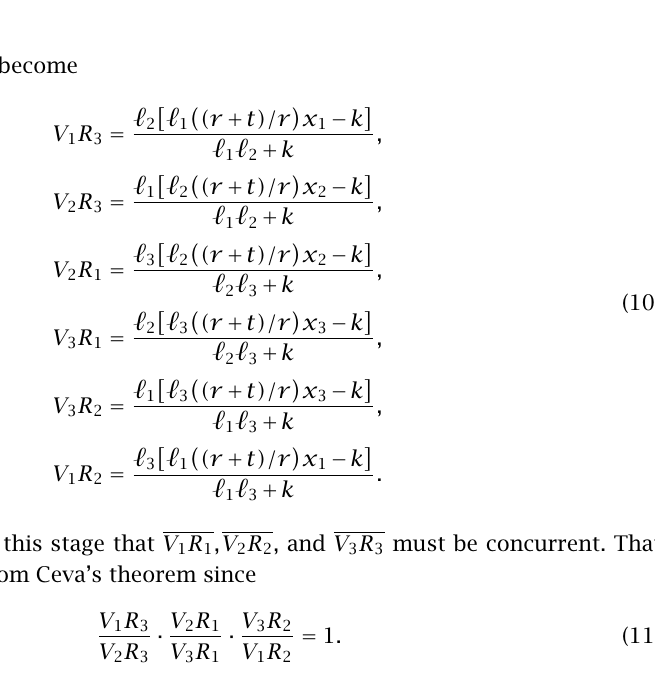
Figure 7 . Similar triangles V 1 V 2 V 3 and ABV 2